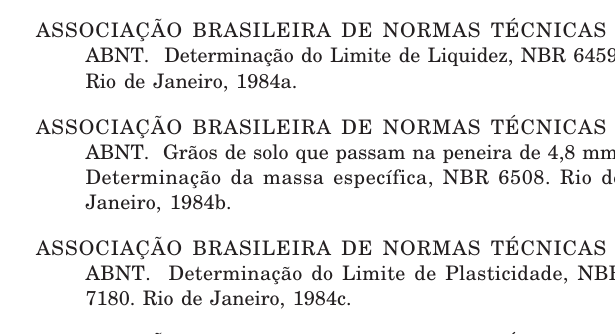
Figura 7. Análise da estabilidade de taludes sem cobertura vegetal e com sete anos de plantio do capim